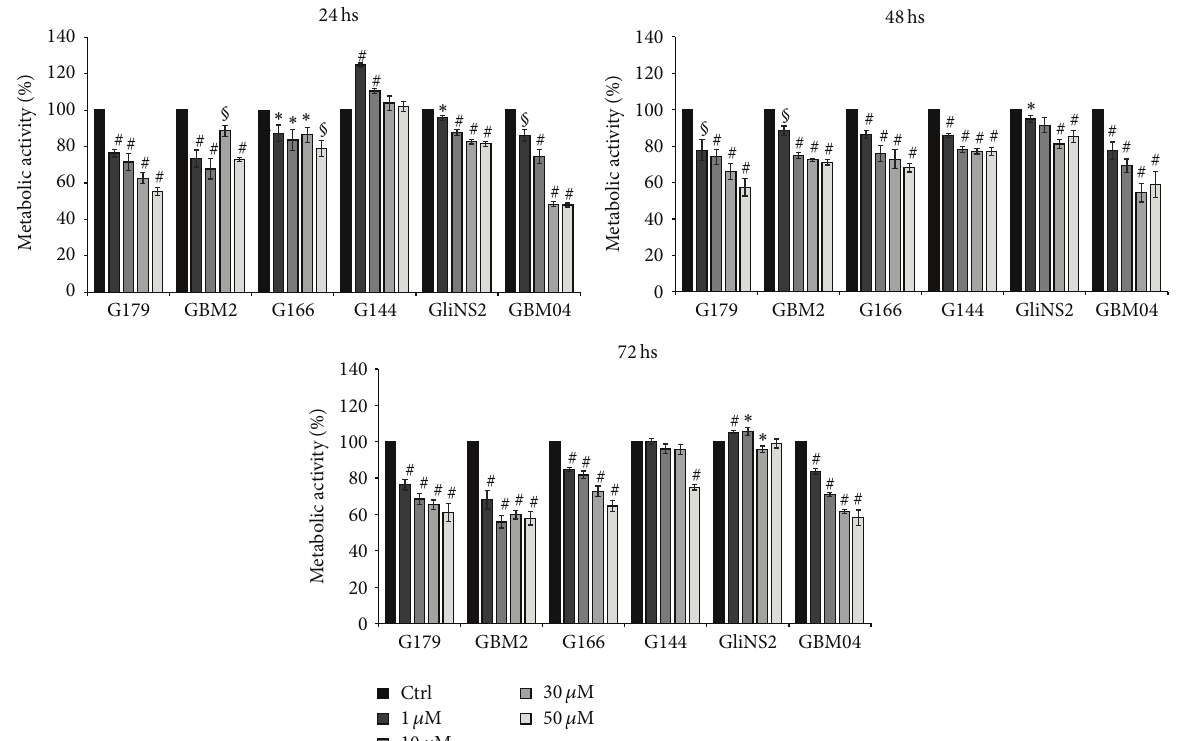
Figure 2: Pio effect on GSC viability. Cell viability was analyzed by MTT assay. Results represent the means from two different experiments performed at least in triplicate and are reported as percentage of drug-treated cells compared to matching untreated cells ± SEM. 𝑡 -test on raw data: ∗ 𝑝 < 0 , 05 ; § 𝑝 < 0, 01 ; # 𝑝 < 0,001 .